Question: What does this figure show? Answer in one sentence.
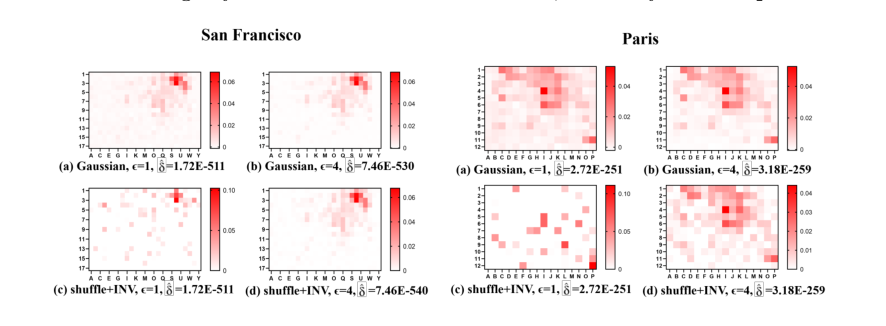
Answer: Estimation of the original distribution from the noisy data obfuscated with the Gaussian mechanism and the SM in San Francisco and Paris dataset